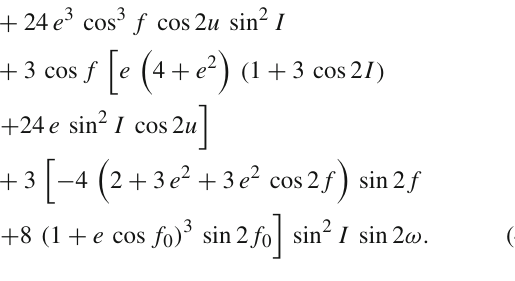
The numerical value of the area under the plot of Eq. (46), depicted in the upper panel of Fig.2, is confirmed by the time series for (cid:8)( t ) produced by numerically integrating the equations of motion of the fictitious satellite of Table1, and displayed in the lower panel of